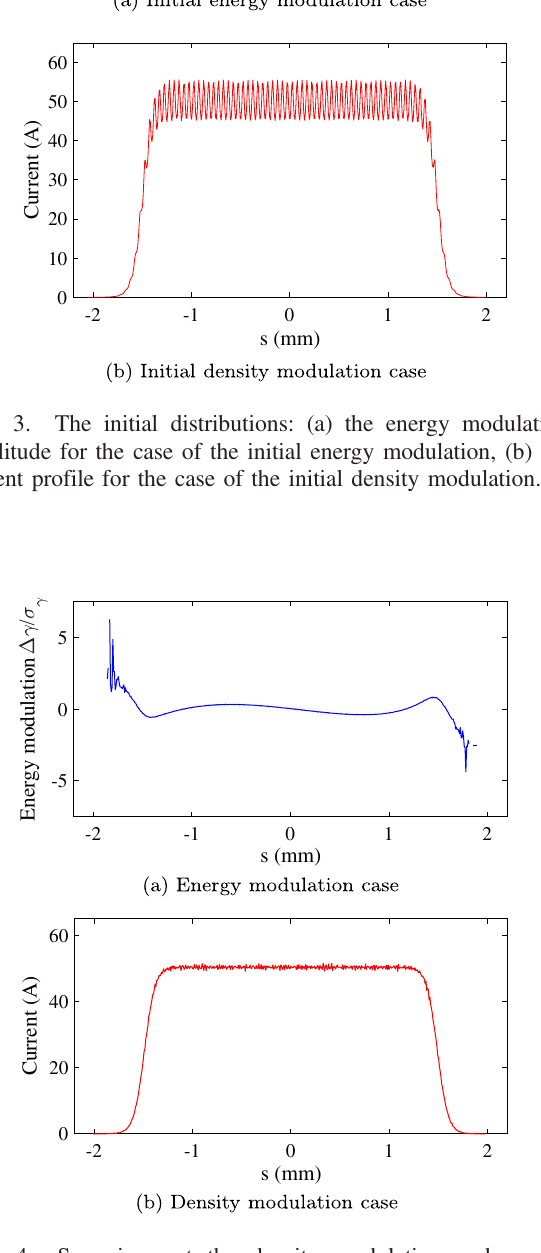
FIG. 4. Smearing out the density modulation and energy modulation due to the heated energy spread and transverse-to- longitudinal coupling upstream of the bunch compressor. Energy chirp in Fig. 4(a) is removed up the 2nd order.